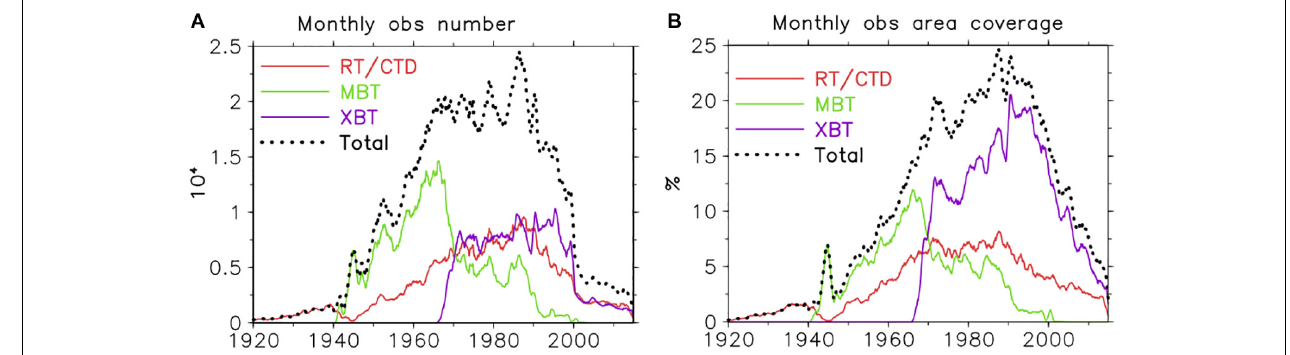
FIGURE 4 | (A) Number and (B) area coverage of monthly measurements from RT/CTD (solid red), MBT (solid green), XBT (solid purple), and total (dotted black) in the global oceans.